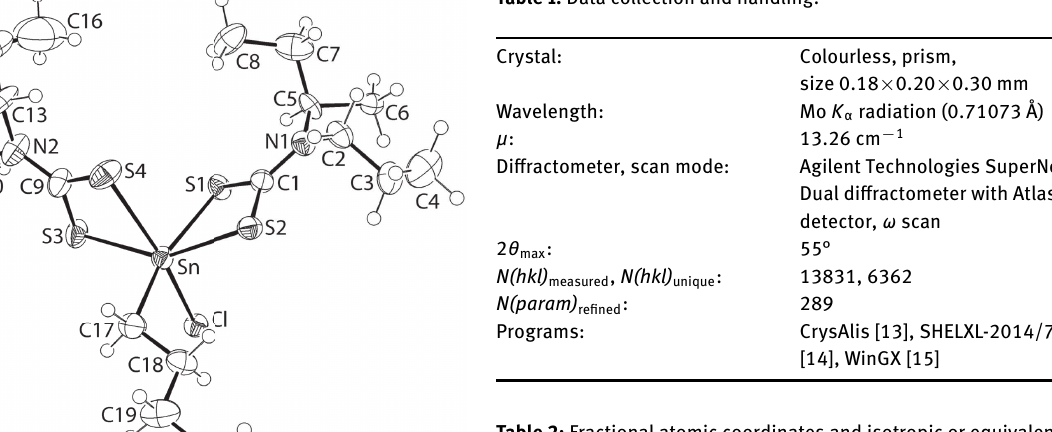
Table 1: Data collection and handling.